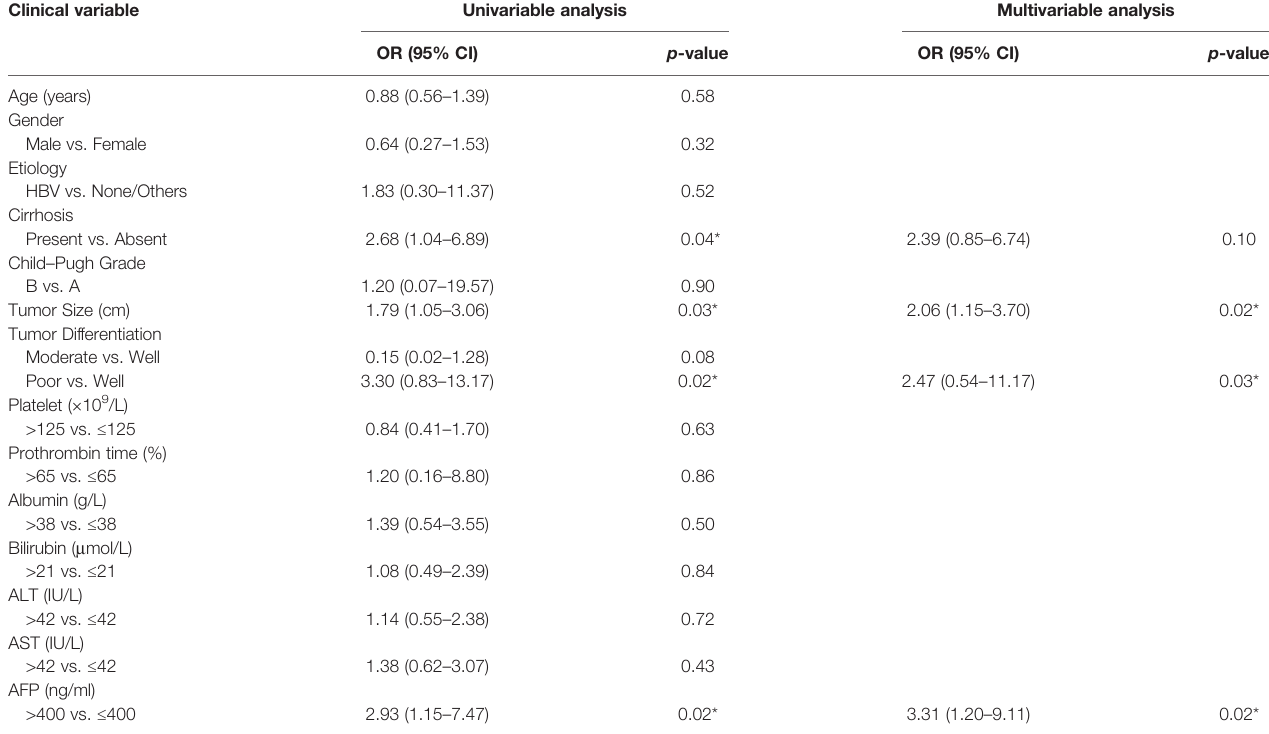
TABLE 2 | Clinical risk factors for MVI presence in patients with hepatocellular carcinoma.